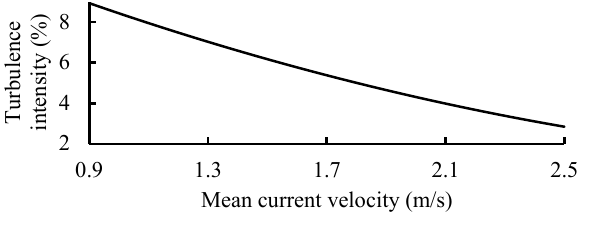
Figure 7. Turbulence at the TCT site.